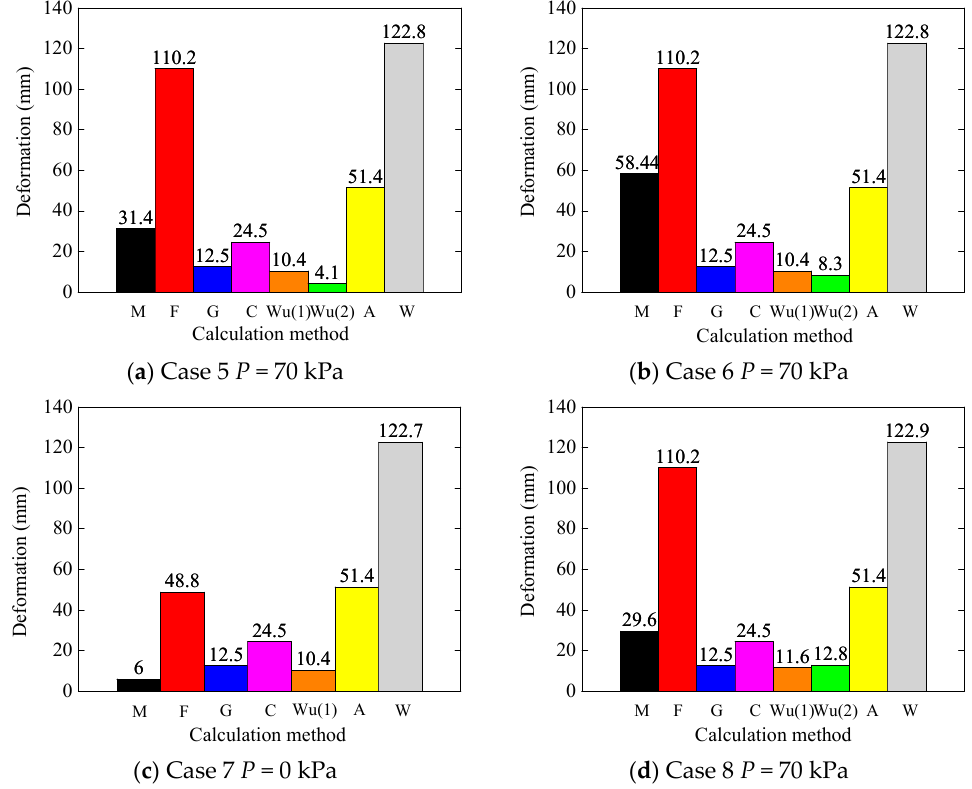
Figure 5. Comparison between measured value and calculated value in case